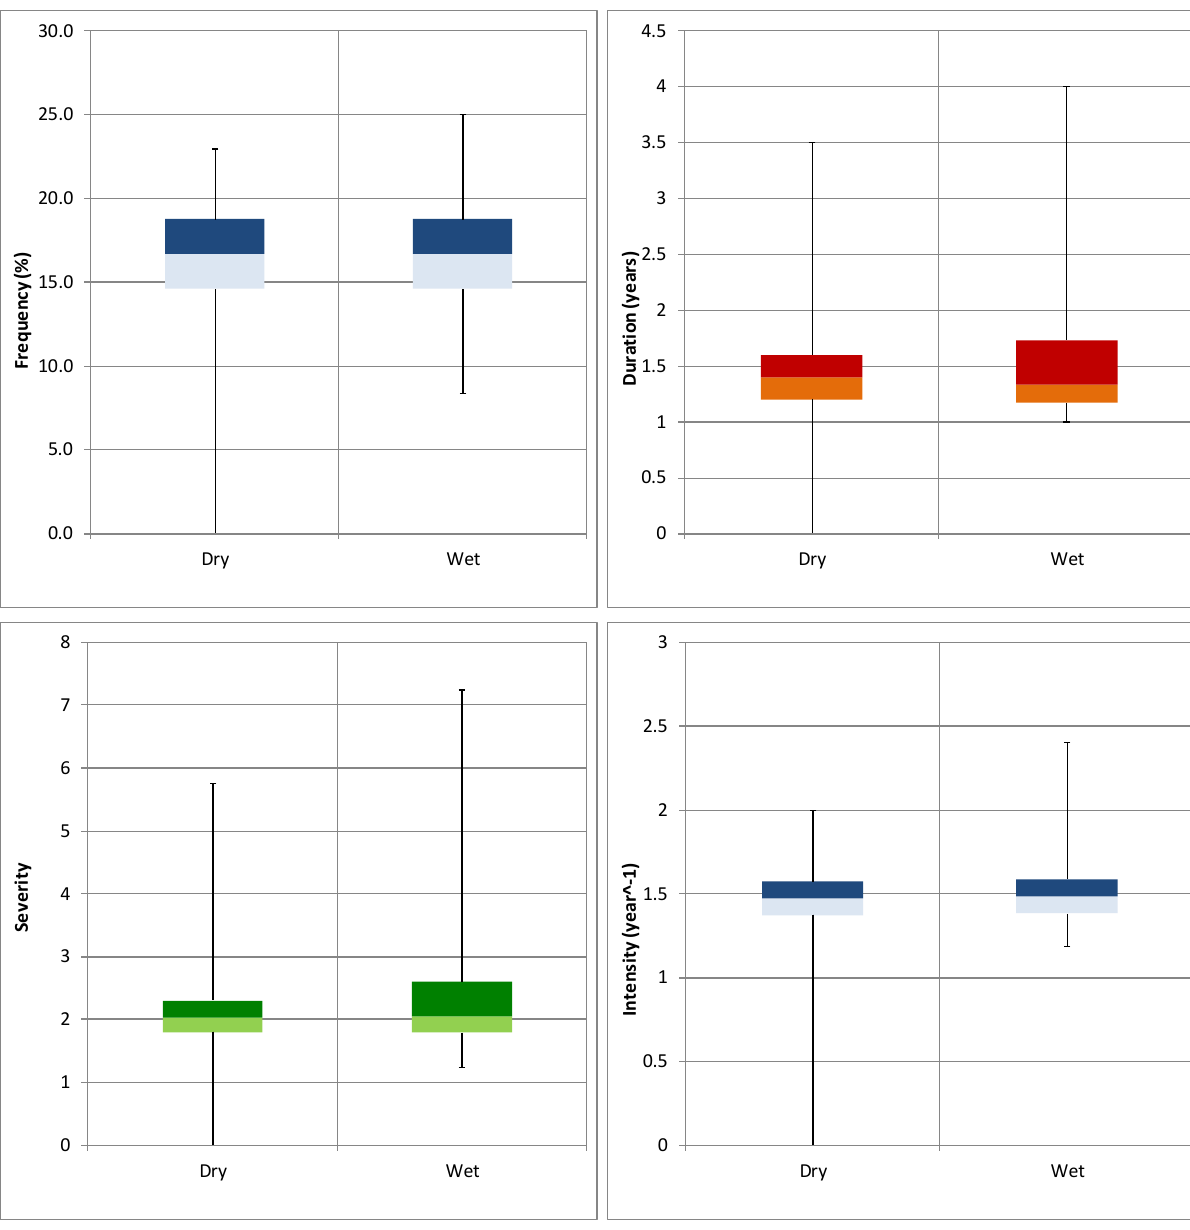
Figure 3. Characterization through boxplots of frequency (%), average duration (in years), average severity, and average intensity (year −1 ). The top and the bottom of the boxes are the third and the second quartiles, respectively; the band inside the box is the median and the ends of the whiskers represent the minimum and maximum of all of the data.